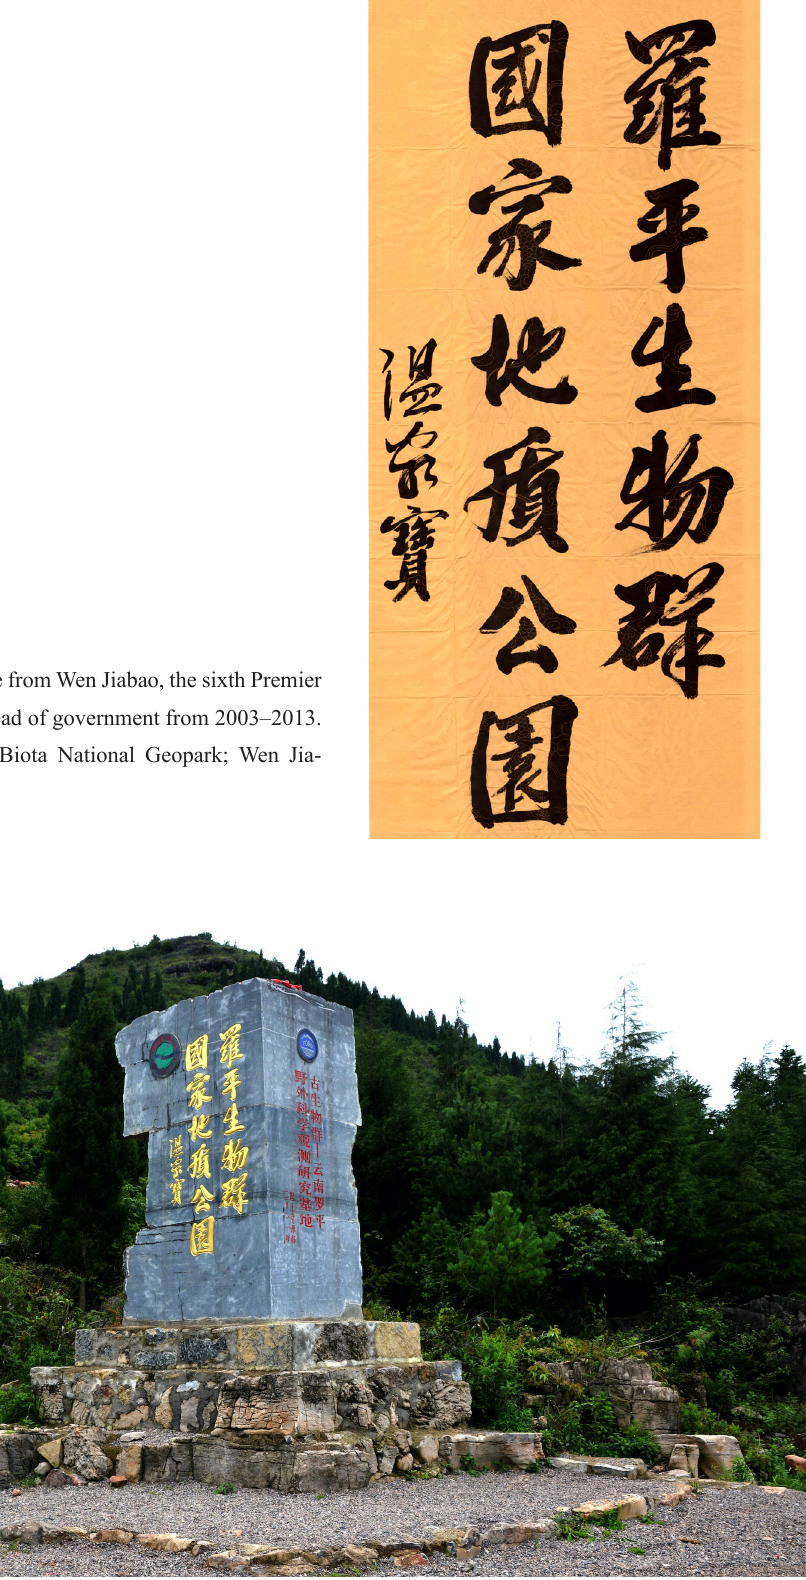
Figure 13. Marker block in the middle of the Luoping Biota National Geopark with Wen Jiabao’s calligraphy on the left. Pho- tograph by